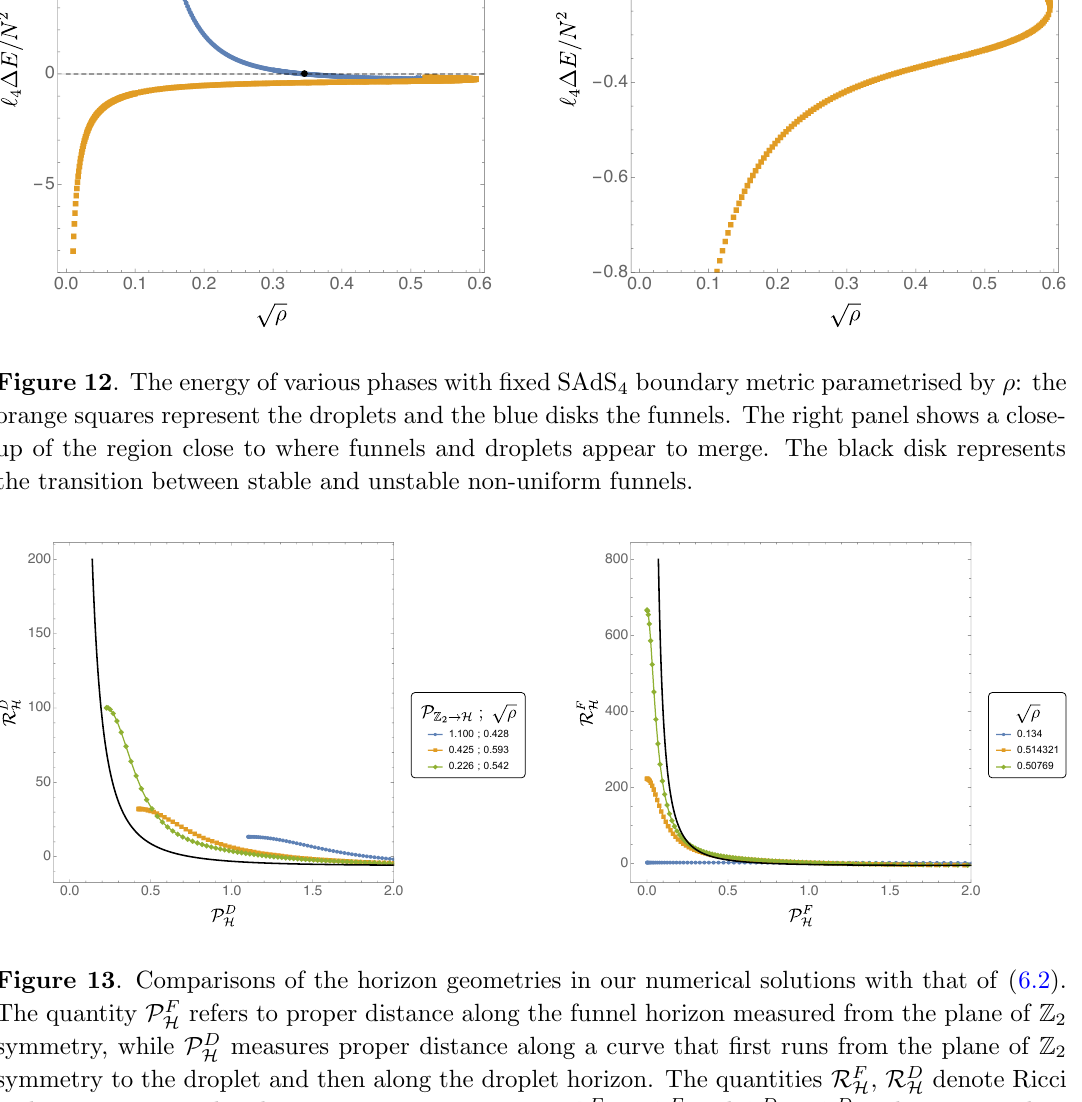
, R D denote Ricci H H vs. R F and R D vs R D with corresponding H H H H